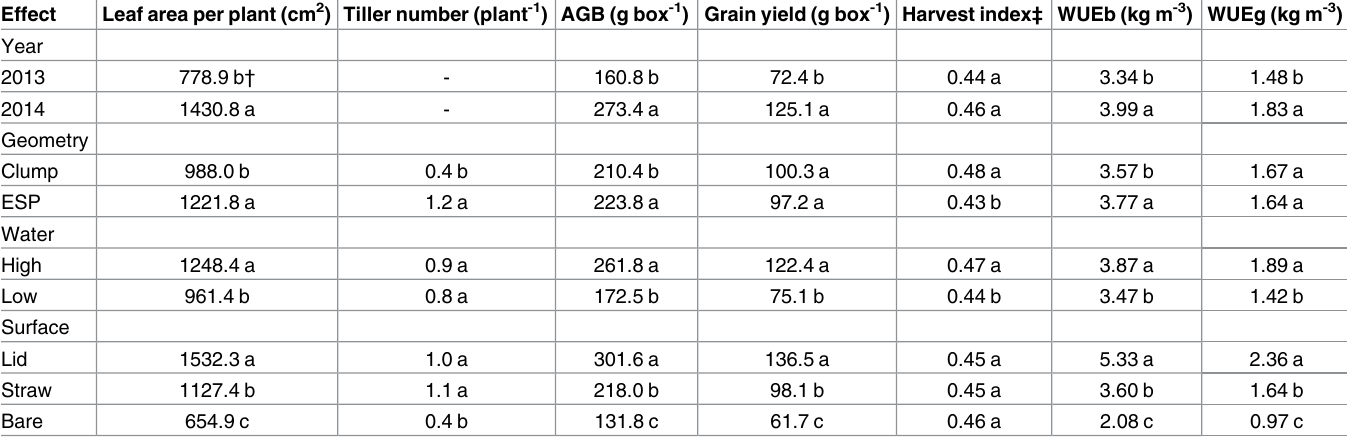
Table 2. Means of Leaf area, tiller number, aboveground biomass (AGB), grain yield, harvest index (HI), biomass water use efficiency (WUEb), and grain water use efficiency (WUEg) of sorghum grown in 2013 and 2014at two planting geometries, two water levels, and three soil surfacetypes.